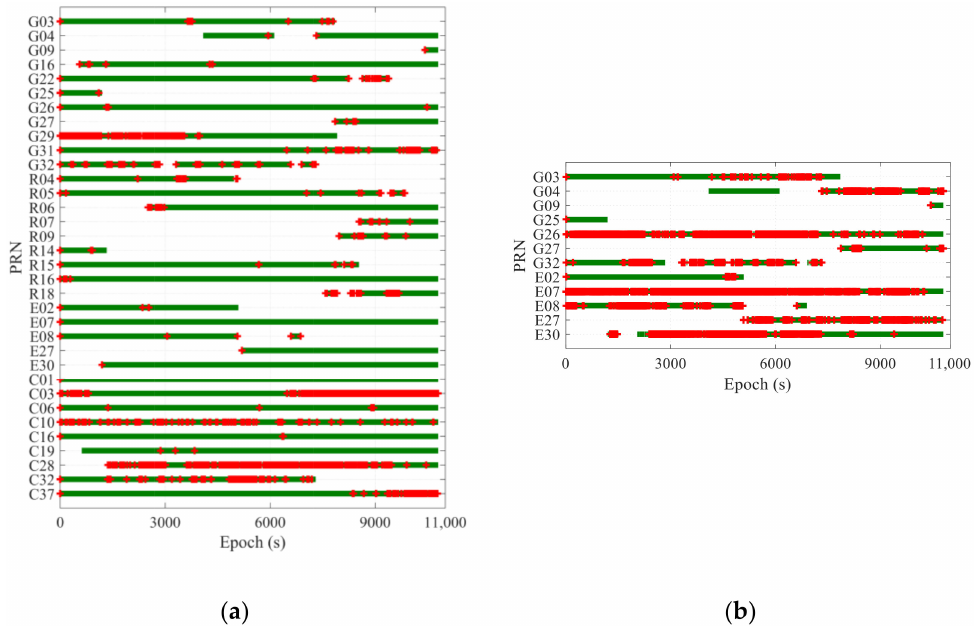
Figure 4. Satellite visibility and cycle slips (red plus signs) of four constellations on two frequency bands: ( a ) global positioning system (GPS) L1/GLONASS G1/Galileo E1/BDS B1; ( b ) GPS L5/Galileo E5a. (PRN, pseudorandom